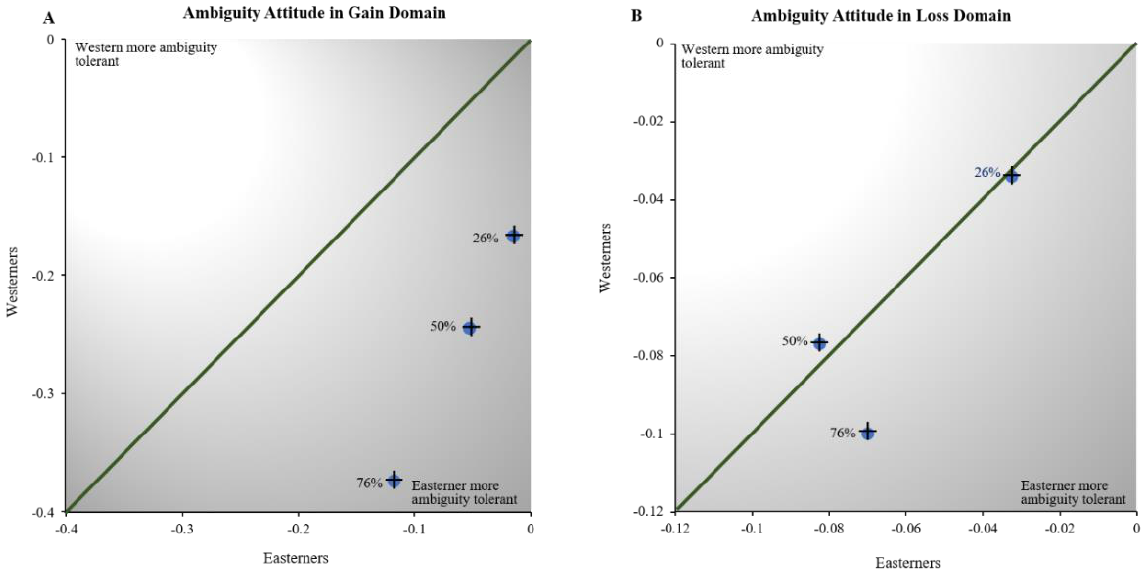
Figure 4. Comparison of ambiguity attitudes in Easterners and Westerners. In ( A ), each point plots the average ambiguity attitude of the Easterners against the ambiguity attitude of the Westerners at each level of ambiguity in the gain domain. In ( B ), each point plots the average ambiguity attitude of the Easterners against the ambiguity attitude of the Westerners at each level of ambiguity in the loss domain.